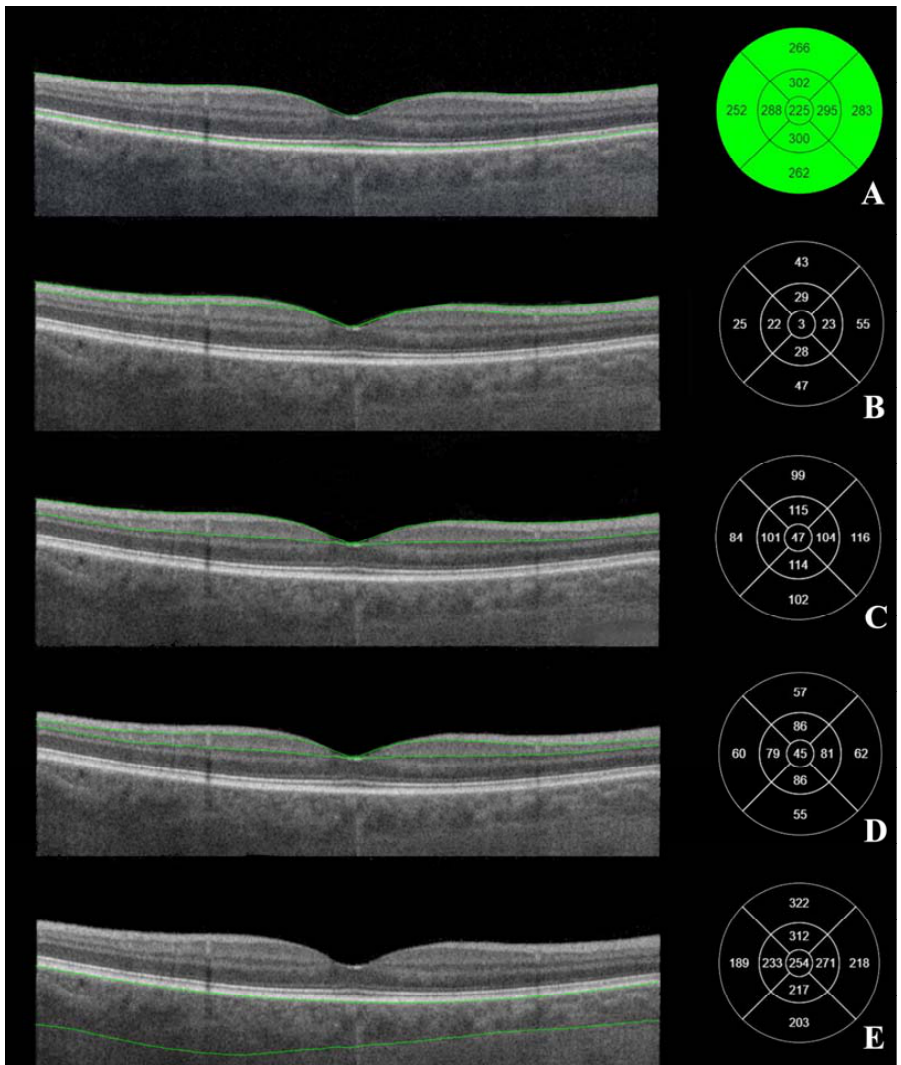
Figure 1. Macular OCT. Macular layers marked on the right. ( A ) the total thickness of the macula, ( B ) retinal nerve fiber layer (from internal limiting membrane to the interface between retinal nerve fiber layer and ganglion cell layer), ( C ) GCL++ layer (from internal limiting membrane to the interface between inner plexiform layer), ( D ) GCL+ layer (from the interface between retinal nerve fiber layer and ganglion cell layer to the interface between inner plexiform layer and inner nuclear layer). ( E ) choroid thickness (from retinal pigment epithelium to the interface between choroid and